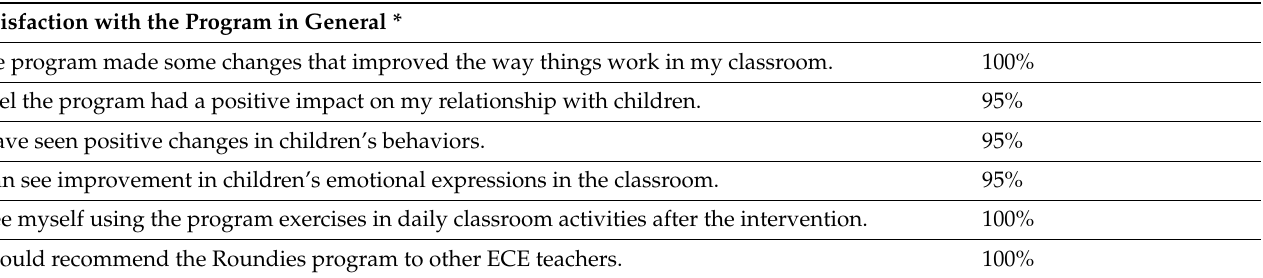
Table 4. Teacher perception of the Roundies program effectiveness and satisfaction with the program components. Satisfaction with the Program in General